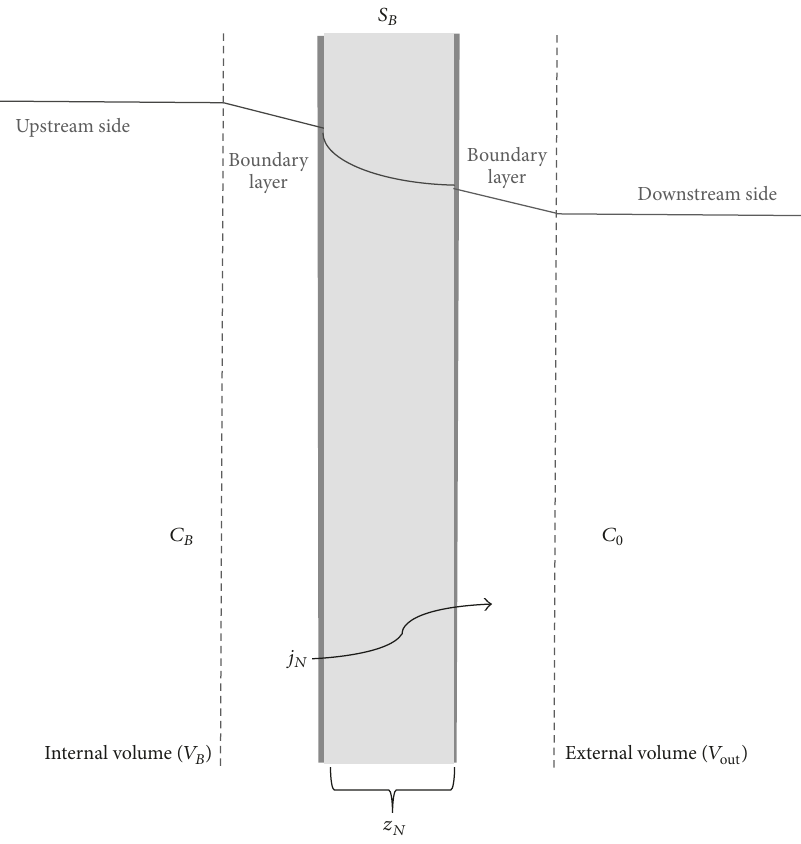
Figure 3: Schematization of diffusion through the thin film of the bag. Table 2: Experimental conditions. The bag tested was without any film inside (B-no film) and with the film inside. The surface of the